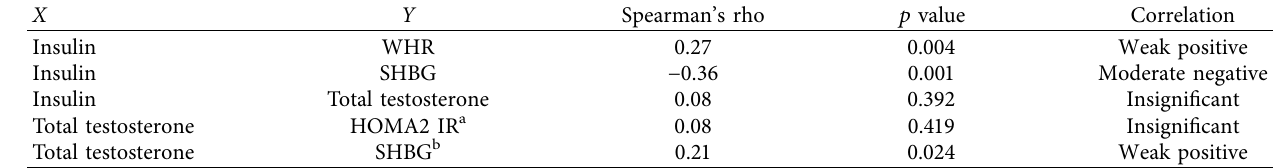
Table 2: Spearman’s rho correlation between testosterone, SHBG, and insulin levels.